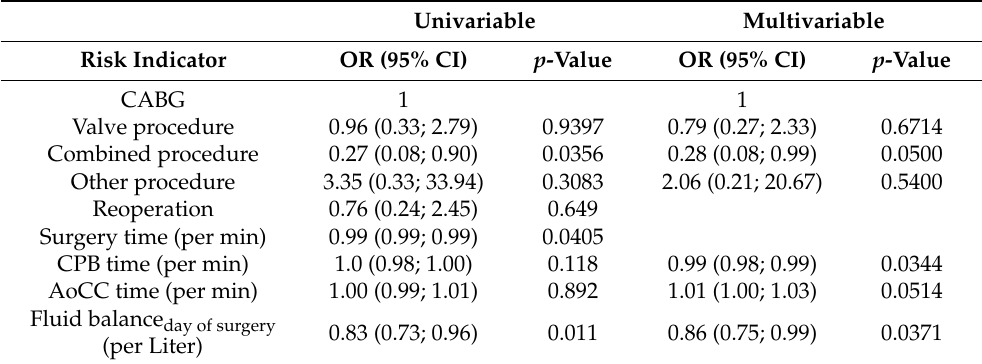
Table 3. Logistic regression analysis of intraoperative risk indicators influencing the nadir phase